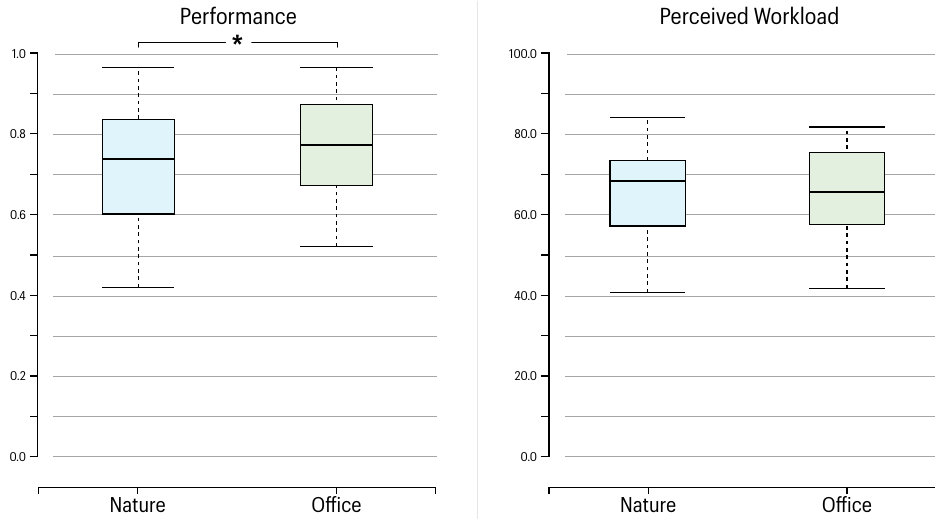
Figure 8. Performance ( left ) and perceived workload ( right ) for the Office and Nature settings. The participant performed significantly better in an Office than in Nature but with a fair workload in both conditions. * indicates significant difference between two conditions with p ≤